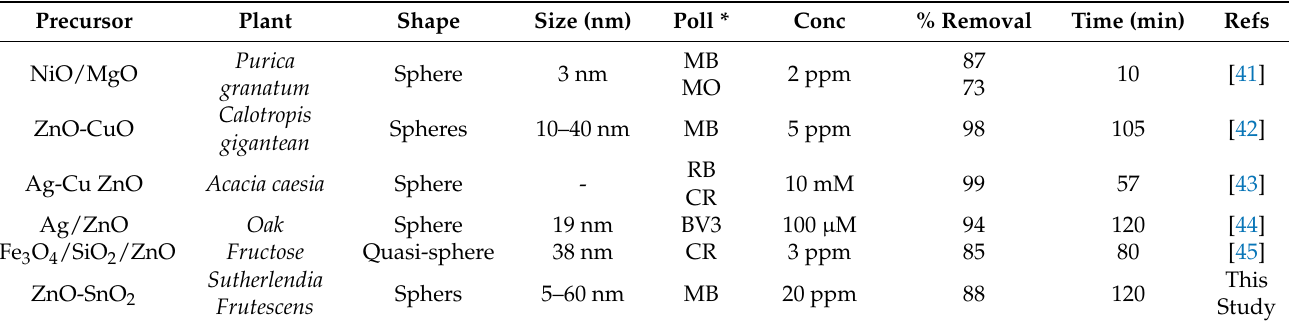
Table 2. Comparison of previously published green derived materials for dye